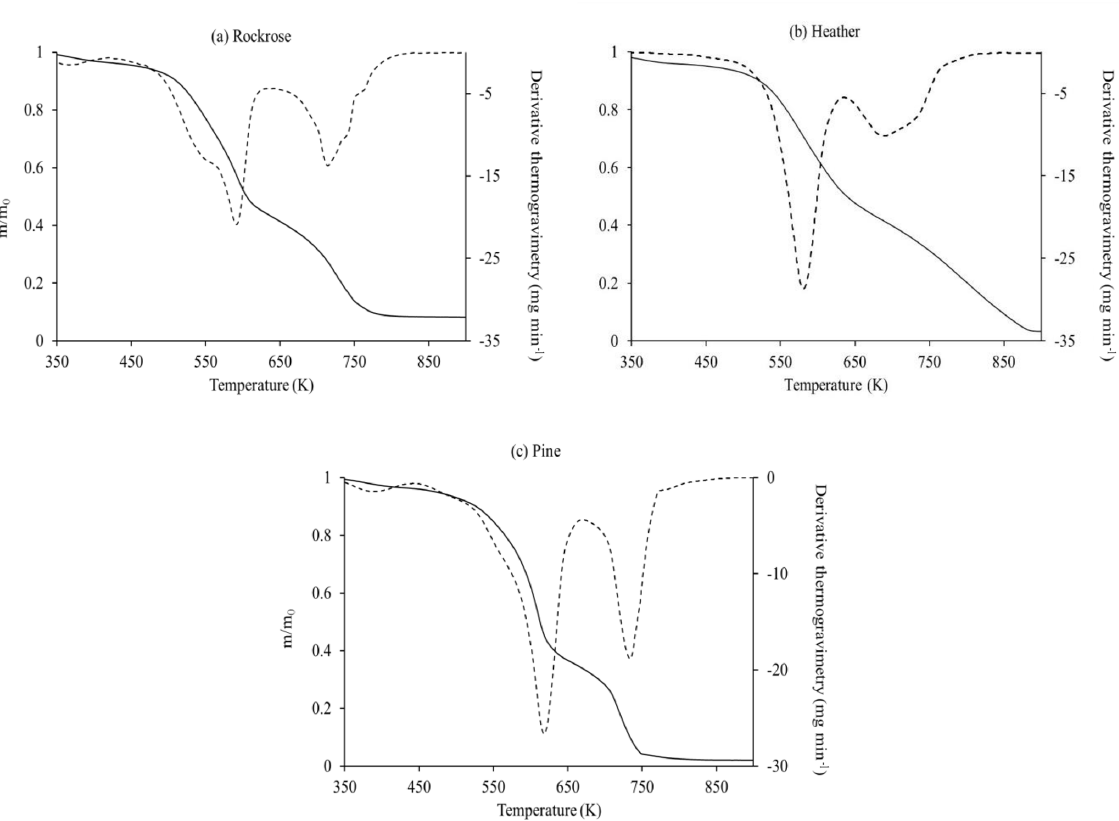
Figure 5. TGA (lines) and DTG (dotted) of oven-dried rockrose (a) , heather (b) and pine (c) samples obtained with a linear heating rate of 30Kmin − 1 under air atmosphere.